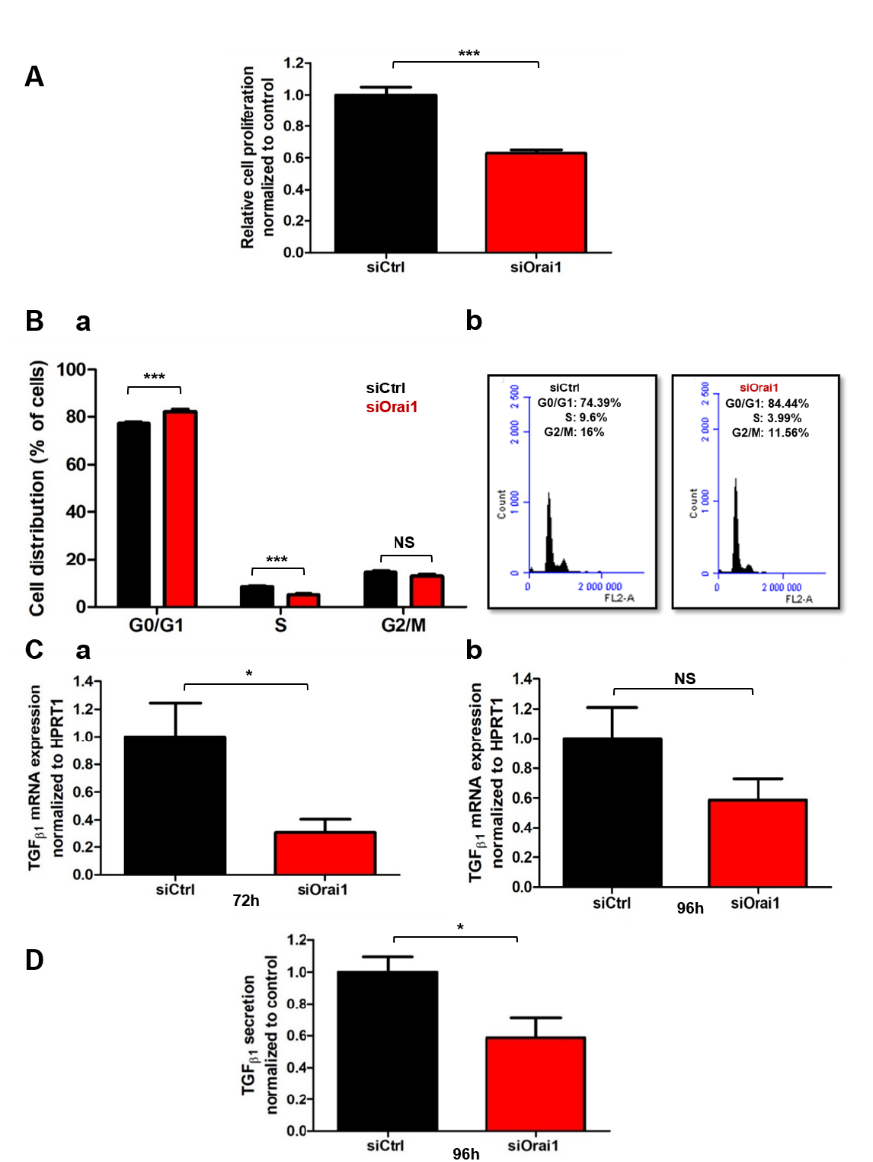
Figure 2. Orai1 modulates human-activated PSC proliferation and TGF β 1 secretion. ( A ) Effect of Orai1 silencing on PS-1 cell proliferation, assessed 72 h post-transfection by MTT assay (*** p < 0.001, N = 4, Student’s t- test). ( B ) Implication of Orai1 in PS-1 cell cycle progression. Cell distribution (G0/G1, S and G2/M phase) was examined by flow cytometry 72 h after transfection, with propidium iodide staining (*** p < 0.001, NS: no significant, N = 3, two-way ANOVA followed by Bonferroni post hoc test, ( Ba ) and represented by an illustrative cell cycle profile 72 h after Orai1 inhibition ( Bb ). ( C ) Impact of Orai1 knocking down on TGF β 1 mRNA expression, evaluated by qPCR, 72 h ( Ca ) and 96 h ( Cb ) post-transfection. ( D ) Role of Orai1 inhibition on TGF β 1 secretion, assessed by ELISA assay, 96 h post-transfection (* p < 0.05, N = 3, Student t- test). Values were normalized to control and reported as mean ± SEM.